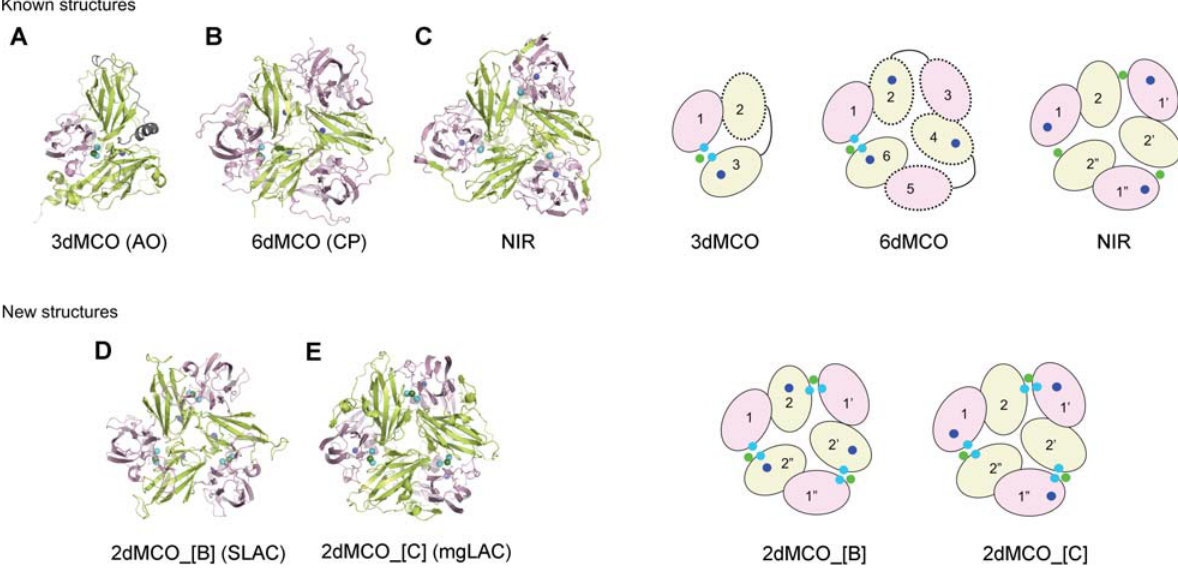
Figure 3 Overall structure of multicopper blue proteins, 3dMCO (AO) (A), 6dMCO (CP) (B), NIR (C), 2dMCO_ w B x (SLAC) (D), and 2dMCO_ w C x (mgLAC)